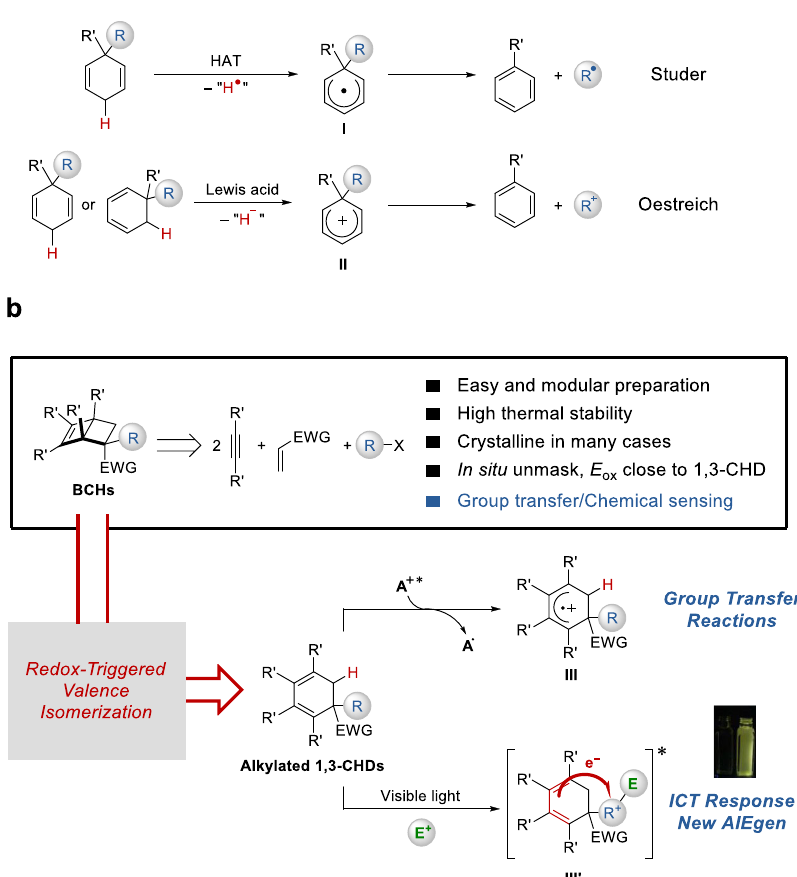
Fig. 1 Searching for new benzene-related proaromatic structures. a Proaromatic CHDs. b Bicyclo[2.2.0]hexene (BCH): proaromaticity via valence isomerism (this work). Utility of BCHs are demonstrated in catalytic group transfer reactions and AIE-active chemical